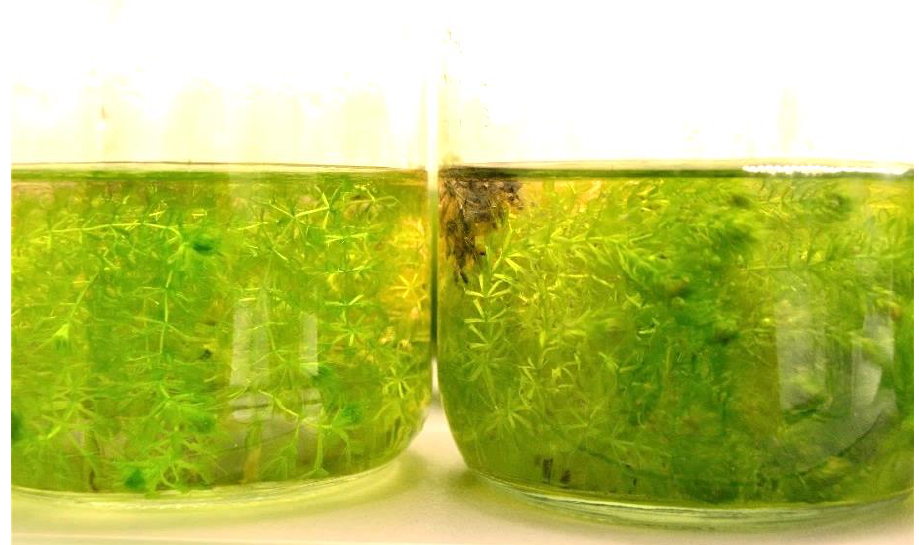
Figure 10. Aldrovanda vesiculosa shoots after 6 weeks in tissue culture (10 plants per 450 mL jar, with 200 mL liquid media).